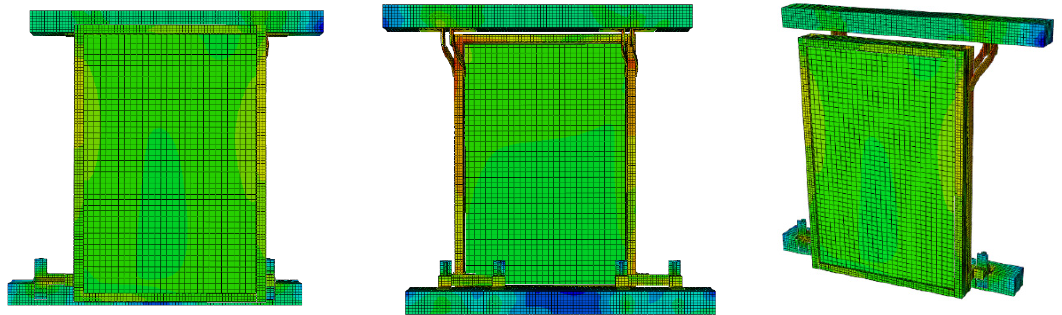
Figure 31. Seismic curtain wall deformation: linear guide length 100